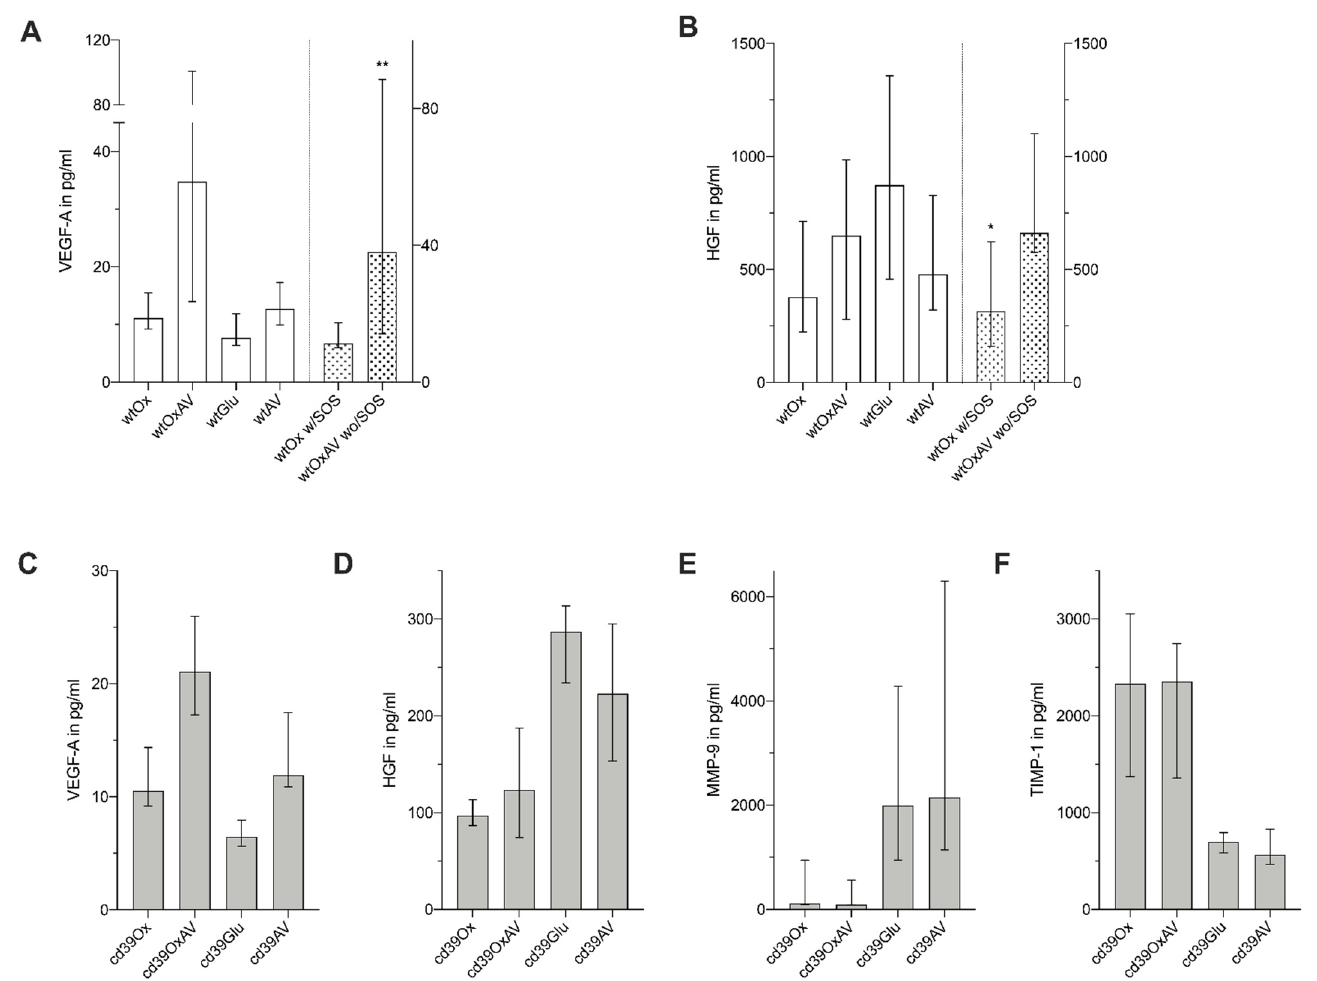
Figure 4. Results of magnetic bead-based assay of blood plasma. Medians and interquartile range. (* p ≤ 0.05, ** p ≤ 0.01) ( A , B ) VEGF-A ( p < 0.0001, A ) and HGF ( p = 0.030, B ) were significantly different among wt mice. The highest values for VEGF-A were found in the wtOxAV group ( A ). For HGF, lowest values were found in the wtOx group ( B ). In the subgroup comparison of wtOx mice with sinusoidal changes and wtOxAV mice without any histological changes, VEGF-A ( p = 0.003, A ) and HGF ( p = 0.040, B ) were significantly increased for wtOxAV. ( C ) cd39OxAV showed the highest values for VEGF-A; however, it was equivalent to cd39AV ( p = 0.193). ( D ) Lowest values for HGF among cd39-null mice were measured for cd39Ox, while control mice (cd39Glu) showed significantly higher values ( p < 0.0001). ( E , F ) cd39-null mice receiving oxaliplatin (cd39Ox and cd39OxAV) showed the lowest values for MMP-9 ( E ) and the highest values for TIMP-1 ( F